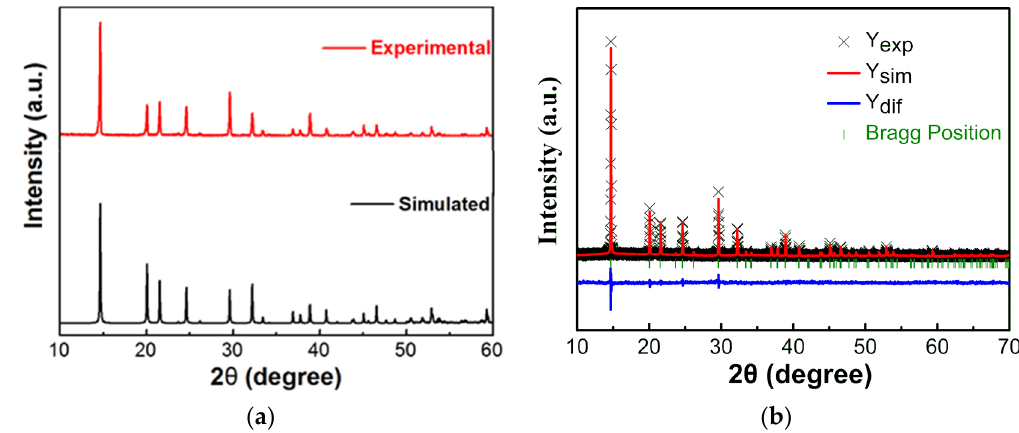
Figure 1. Powder XRD patterns of [(CH 3 ) 2 NH 2 ][Fe(HCOO) 3 ] at room temperature, ( a ) the experimental and simulated XRD patterns, ( b ) Rietveld fit of XRD pattern. The simulated XRD pattern was for rhombohedral R 3(cid:3364) c structure (CCDC 780885) [17].